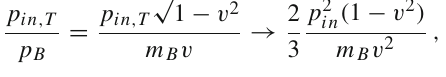
axis. It is clear that magnitudes like this, which can change sign from one model to another, should be very useful in the search of contributions